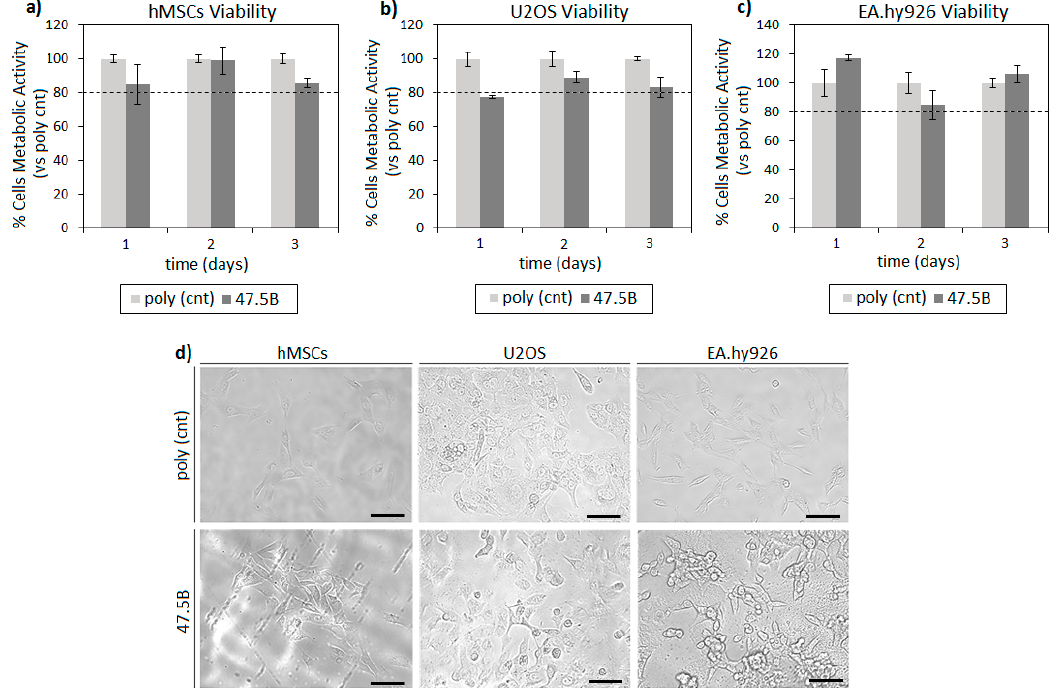
Figure 3. In vitro cytocompatibility of 47.5 B specimens. Results were comparable (>80%, p > 0.05) between tested BG and polystyrene control (poly cnt) at each time point for all the cell lines ( a – c , bars represent mean ± standard deviation of three replicates). Moreover, optical microscope visual observation ( d ) revealed cells displaying similar morphology, spread and confluence between polystyrene (upper panel) and BG (lower panel). Image bar scale = 100 μ m.